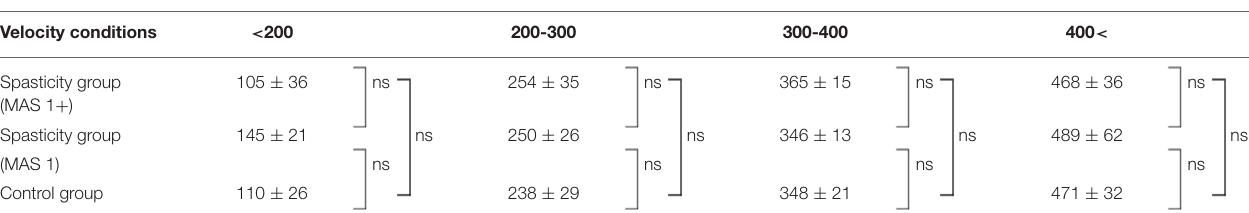
TABLE 3 | Average velocities in four velocity